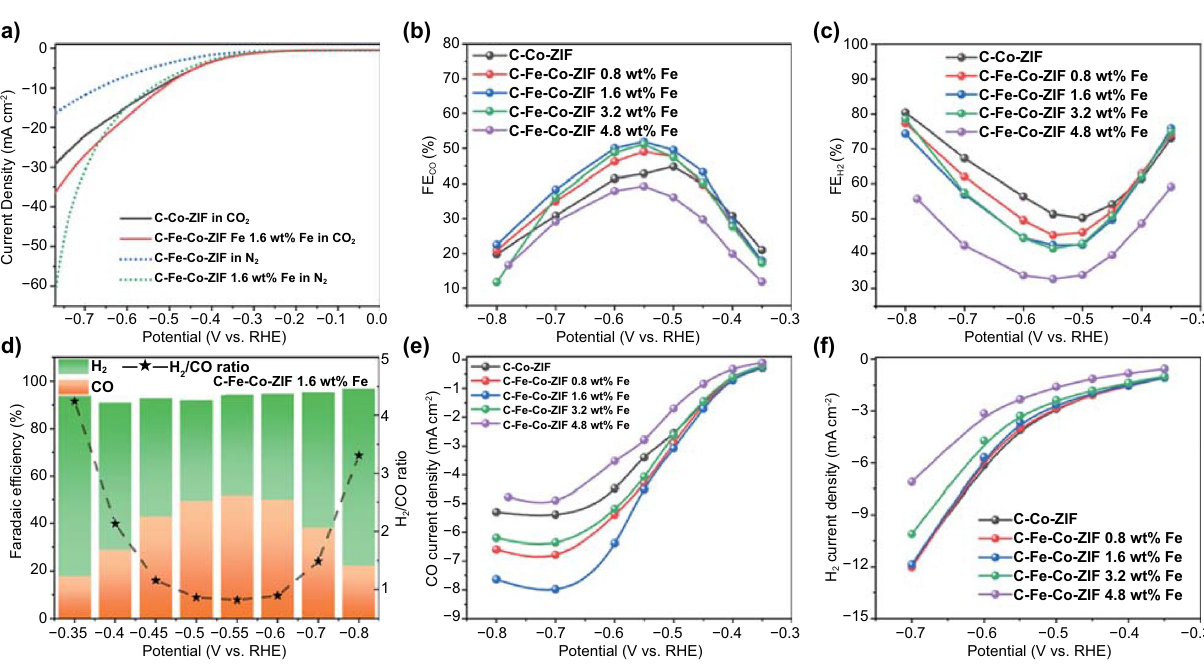
Fig. 6 Evaluation of the electrocatalytic performance of the samples. a LSV curves of C–Co-ZIF and C–Fe–Co–ZIF-1.6 wt%-Fe in N 2 or CO 2 -saturated 0.5 M KHCO 3 solution at a scan rate of 5 mV s −1 . b CO Faradaic efficiency of the catalysts at various applied potentials. c H 2 Faradaic efficiency of the catalysts at various applied potentials. d Bars: FE CO and FE H2 ; Stars: H 2 /CO ratio of C–Fe–Co–ZIF-1.6 wt%-Fe at various applied potentials. e CO current density of the catalysts. f H 2 current density of the